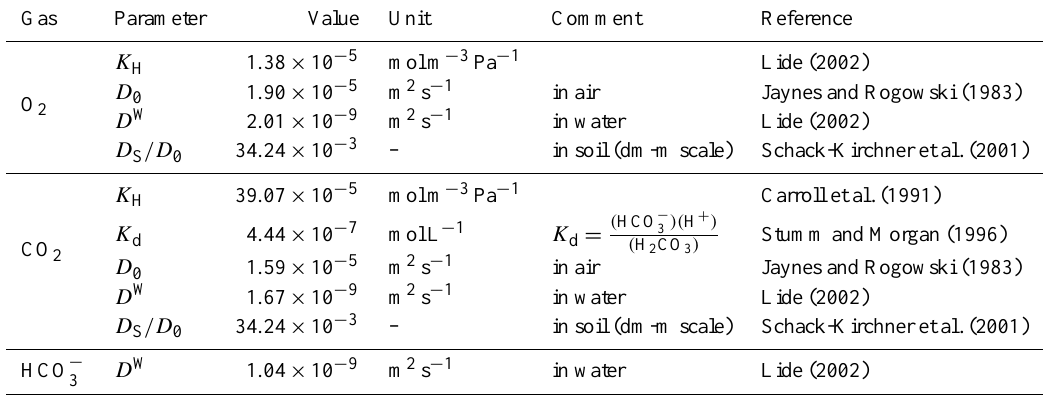
for a temperature of 293K. The temperature 3